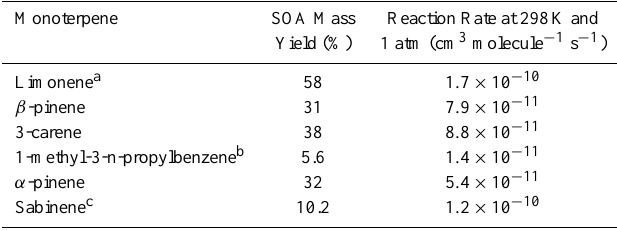
Table 2. Photooxidation SOA yields from Lee et al. (2006b, or other studies as noted) and reaction rates from Atkinson et al. (1997). Primary oxidant OH.